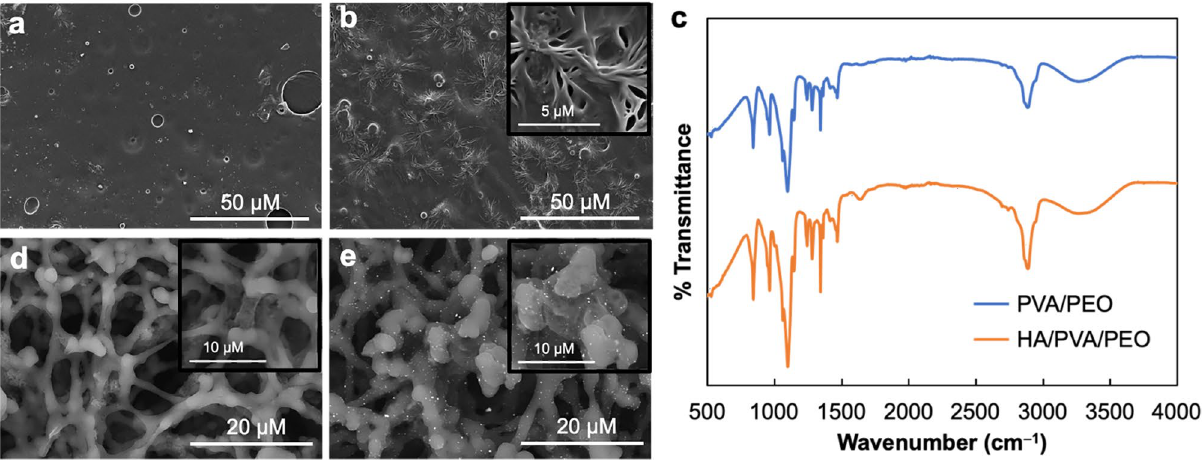
Figure 3. SEM images of ( a ) PVA/PEO and ( b ) HA/PVA/PEO blend films with magnifications of 1000× and 10,000× (inset); ( c ) FTIR spectra of PVA/PEO and HA/PVA/PEO blend films; SEM images of T lines on the NCM ( d ) before and ( e ) after gold enlargement with magnifications of 2500× and 5000× (inset) using backscattered electron (BSE)